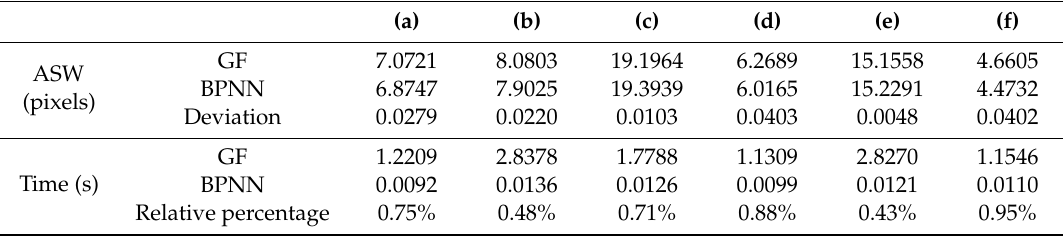
Table 1. Comparison of Gaussian fitting (GF) method with the back propagation neural network (BPNN)